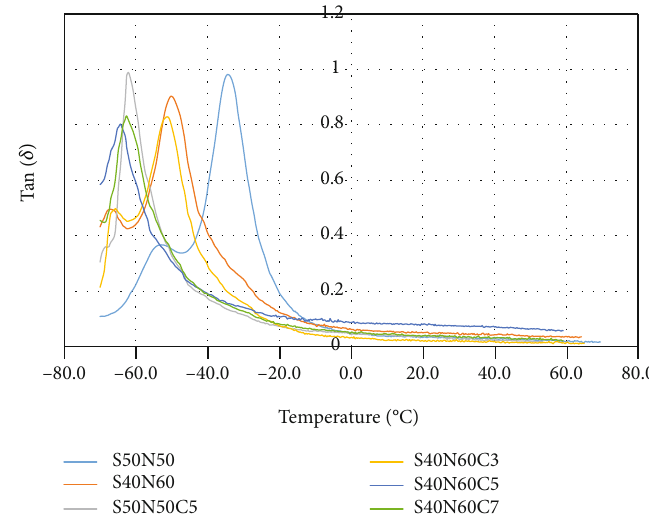
Figure 18: Dynamic loss factor (tan δ ) as a function of temperature (T) for rubber samples.